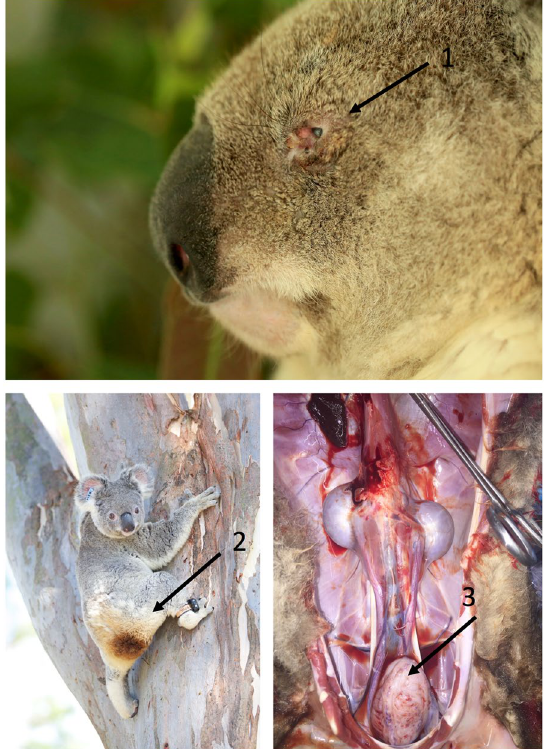
Figure 1. Keratoconjunctivitis (1) and cystitis (bladder inflammation) causing “wet bottom” or “dirty tail” (2) and are two of the clinical manifestations of overt Chlamydia pecorum disease seen in koalas ( Phascolarctos cinereus ); and haemorrhage and thickening of the bladder wall (3) is common in chronic